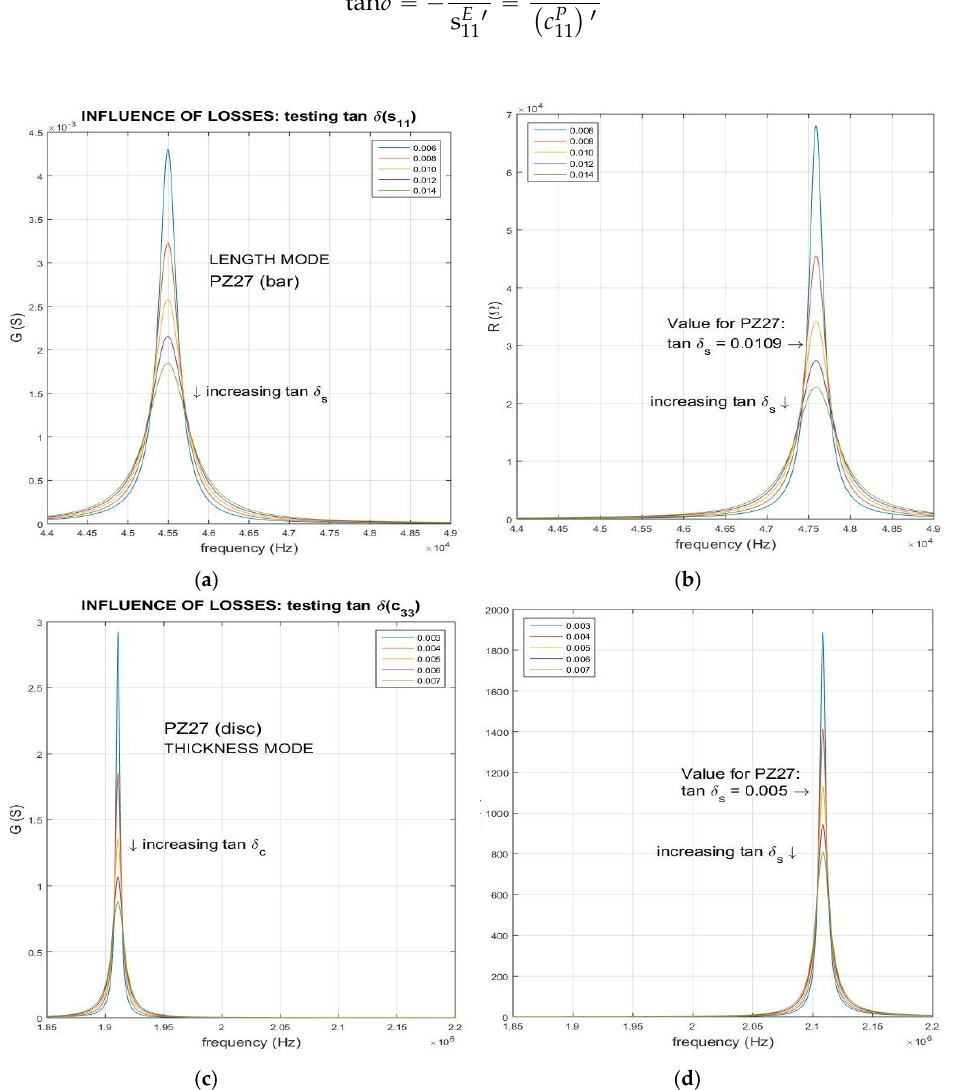
Figure 6. Influence of mechanical losses on the ( a ) and ( c ) resonance G ‐ peaks, and ( b ) and ( d ) anti ‐ resonance R ‐ peaks. The increment of the losses of the elastic parameter (compliance) affects both peaks in the same way .